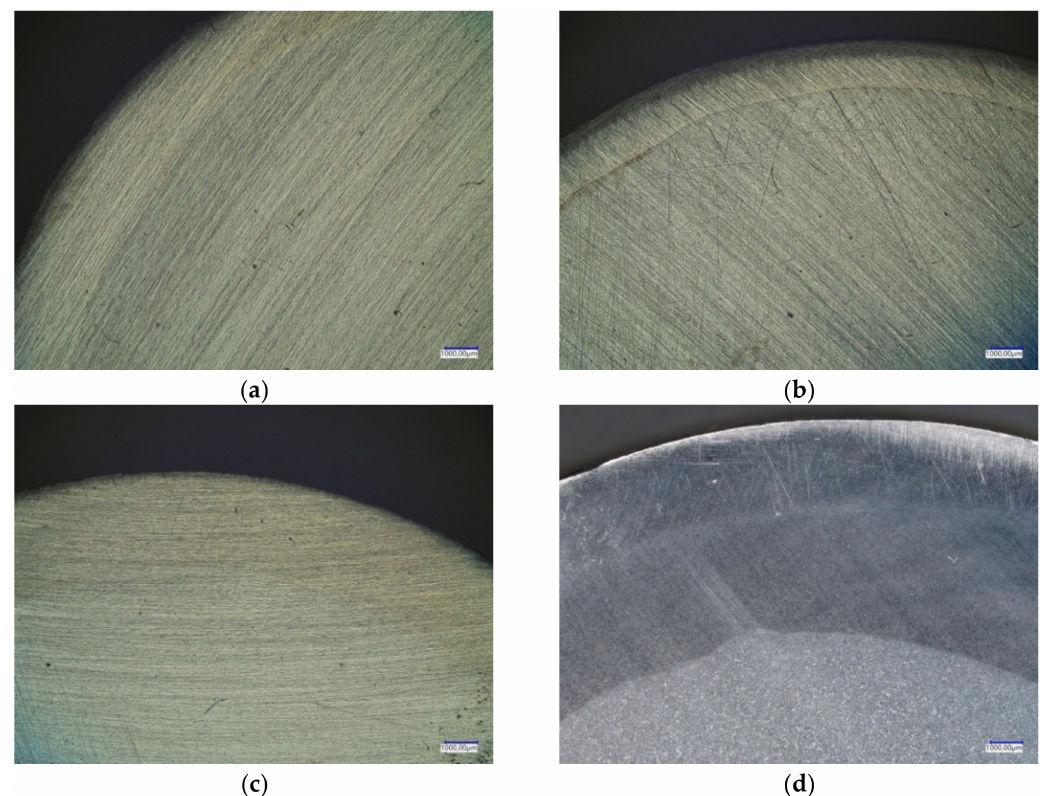
Figure 8. View of the surfaces of cross-sections of bimetallic rods: ( a ) variant I, ( b ) variant II, ( c ) variant III, and ( d ) variant V of the experiment (as described in Table